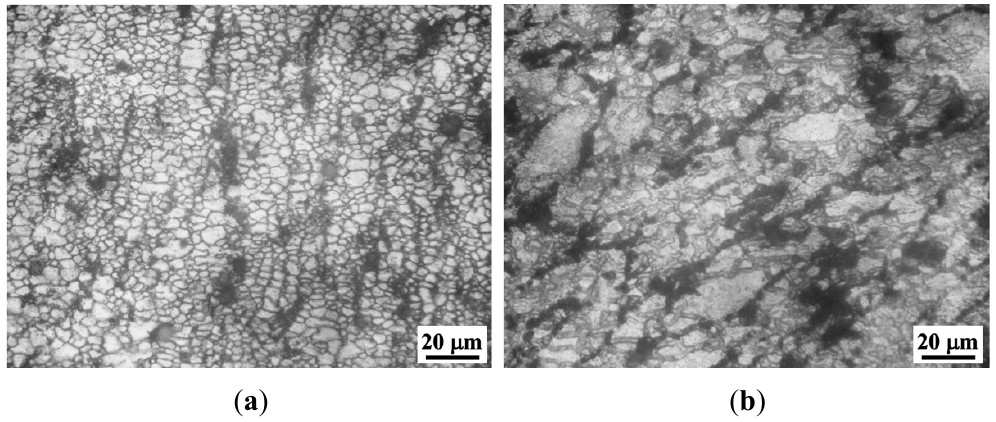
Figure 9. Microstructures obtained on DMD processed AZ31-3Ca alloy specimens deformed at ( a ) 400 ◦ C / 0.001 s − 1 ( b ) 400 ◦ C / 0.01 s − 1 (near bifurcation region).